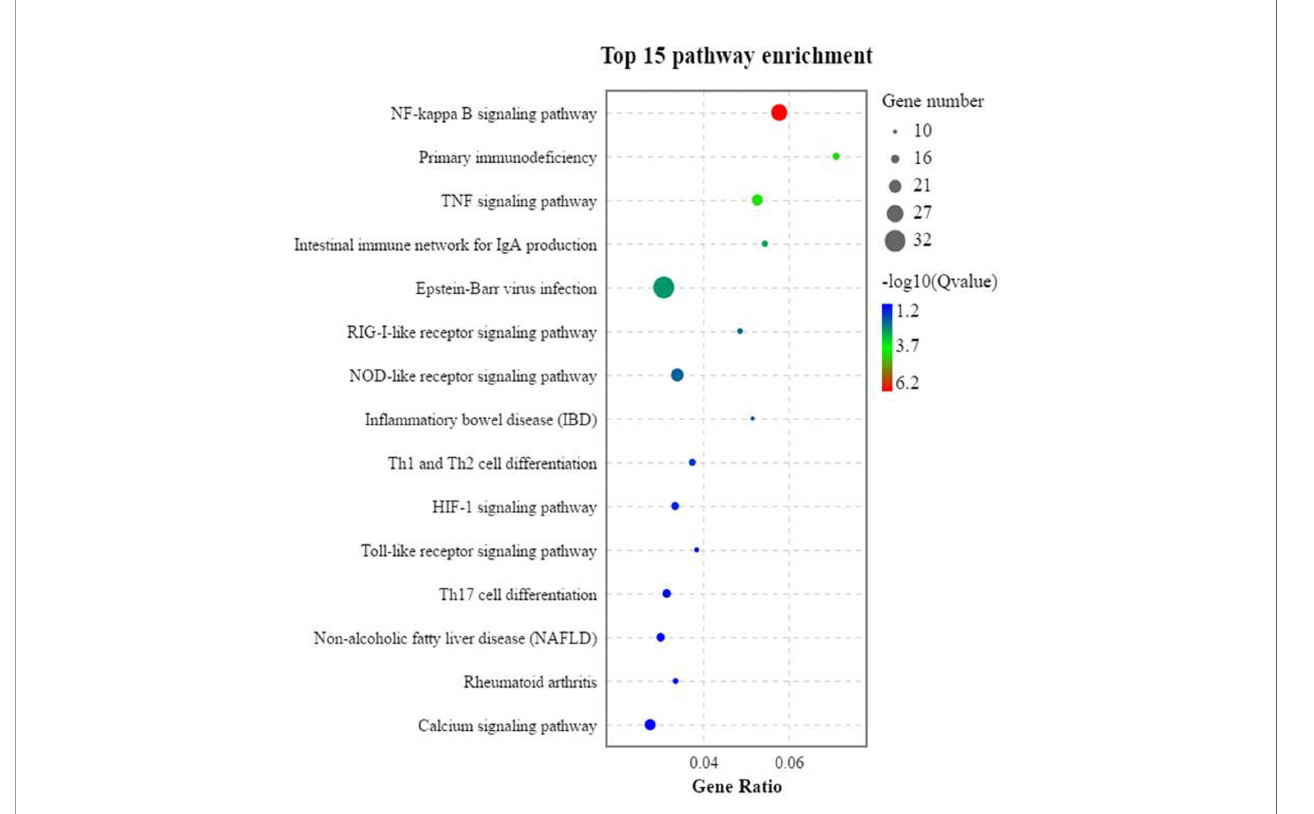
FIGURE 6 | The trend analysis of the signi fi cantly activated KEGG pathways of the DEGs ( n =